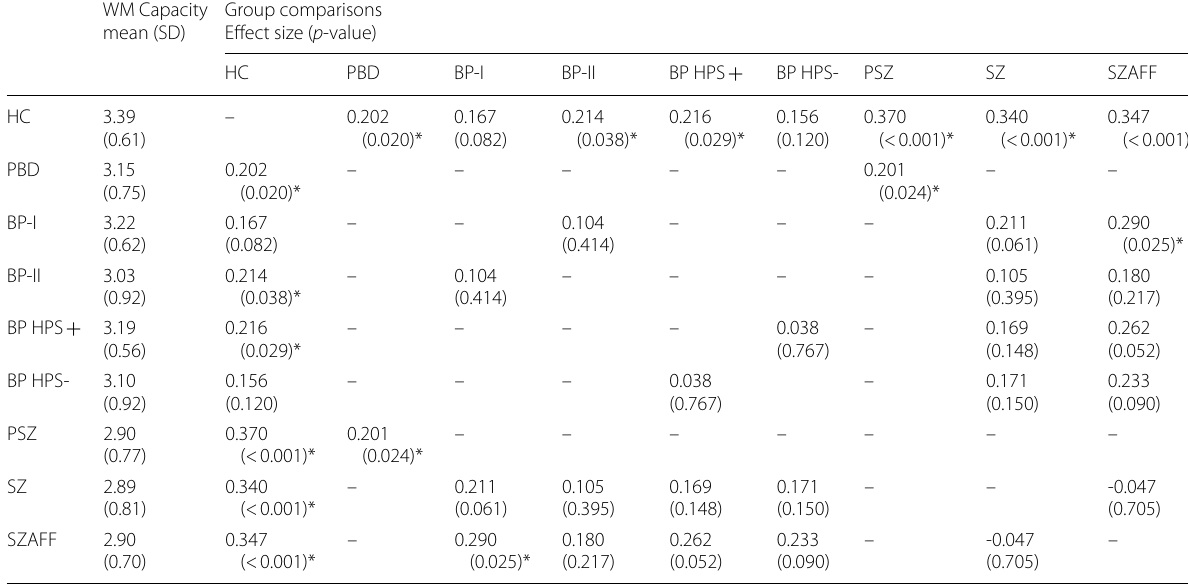
Results of Mann–Whitney U tests to test pairwise comparisons of working memory capacity estimated with Pashler’s K and reported as effect size ( r p ‑value. HC healthy controls, PBD patients with bipolar disorder, BP‑I patients with bipolar type I, BP‑II = = = patients with history of psychotic symptoms, BP HPS‑ bipolar patients without history of psychotic symptoms, PSZ = schizophrenia, SZAFF patients with schizoaffective disorder. Statistical significance is indicated by =